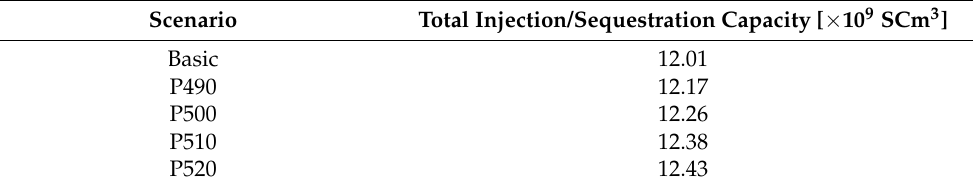
Figure 24. Total CO 2 injections for various injection scenarios.